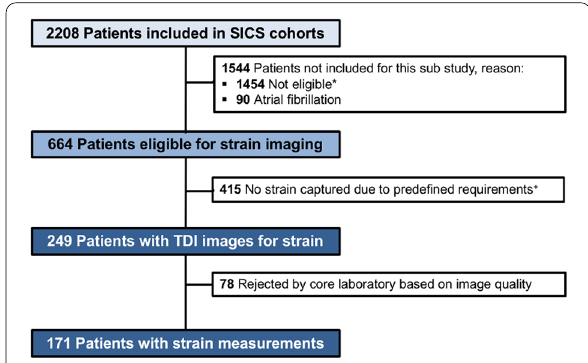
Fig. 1 Study flowchart. *Mostly due to inclusion in SICS before sub-study started or not eligible for CCE in SICS-II. + The predefined requirements were: a stable echocardiogram (ECG), an apical four-chamber view (AP4CH) with the myocardial wall clearly visualized and defined, a maximum angle deviation of 15 degrees between the segment of interest and the contraction axis to limit errors caused by angle deviation and a frame rate of at least 160 frames per second for optimal offline strain